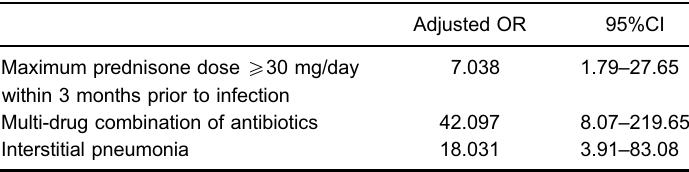
Table 3. Logistic regression analysis of risk factors of patients with connective tissue disease (CTD) associated with invasive pulmonary fungal